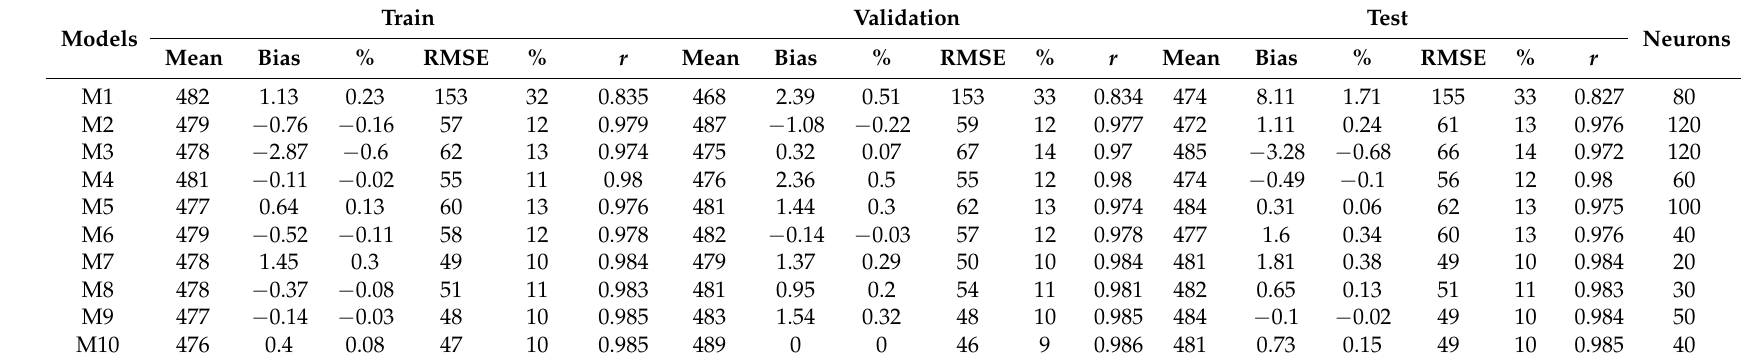
Table A6. As in Table A1, but for Halsho automatic